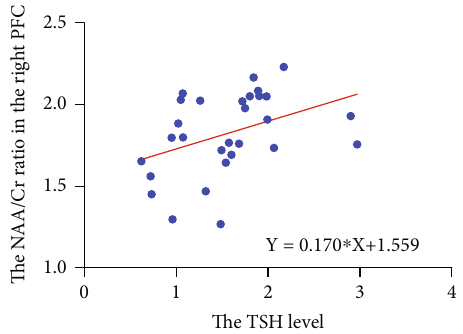
Figure 6: Correlations between clinical variables, biochemical metabolite ratios, cognitive function, and TSH